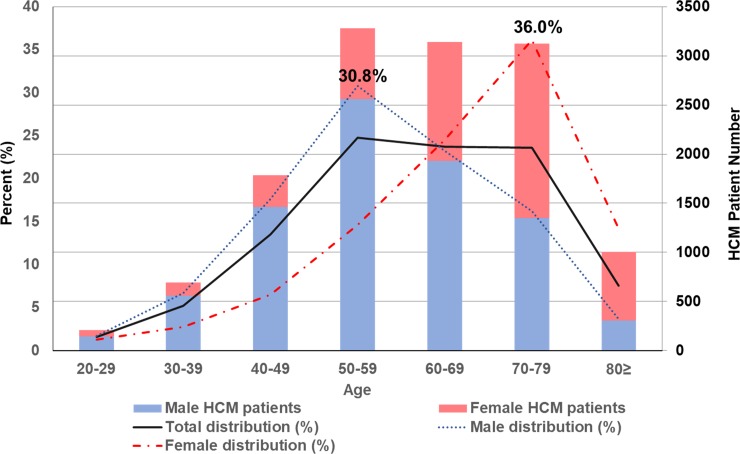
Age distribution of the newly-diagnosed HCM cohort by gender.HCM = hypertrophic cardiomyopathy.